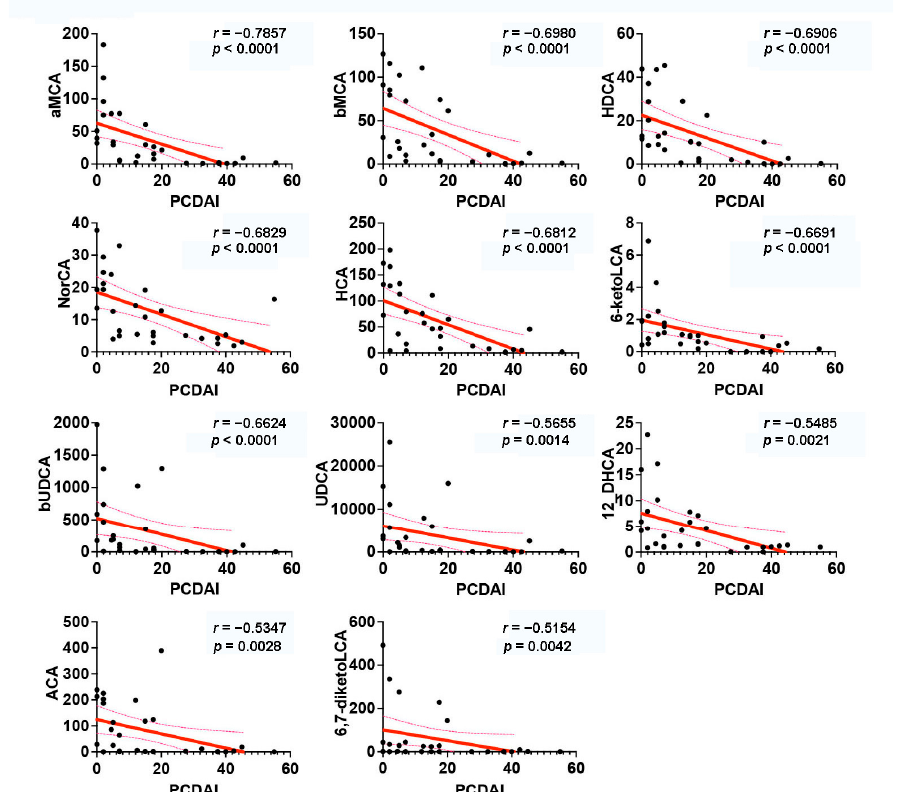
Figure 8. Interrelationships between bile acid profiles and PCDAI in CD. Significant correlations were identified by Spearman correlations with p < 0.05 and | r | > 0.5. CD, Crohn’s disease;